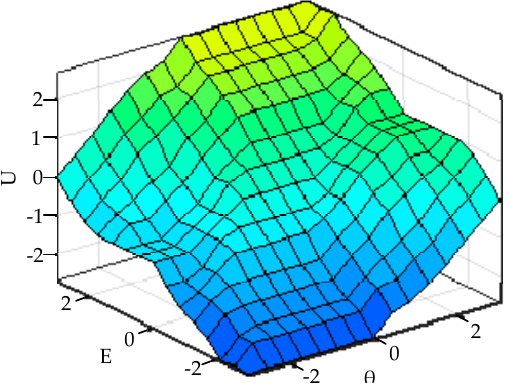
3 Figure 7. The distribution of the membership function of θ , E, and U. The MIN-MAX-gravity method is selected for defuzzification. According to experience and the test conditions, the table of fuzzy control rules is shown in Table 1. Figure 8 shows the three- dimensional surface diagram of the fuzzy control rules. Table 1. The fuzzy control rules. U